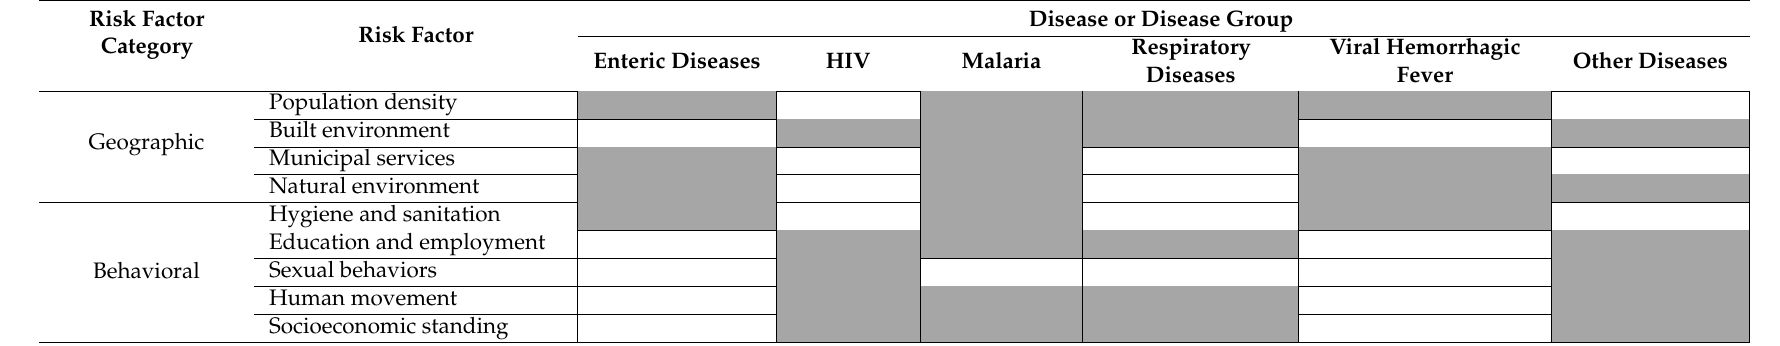
Table 2. Summary of identified geographic and behavior risk factors per disease group. Grey fill designates where a risk factor was identified in one or more papers related to the indicated disease or disease